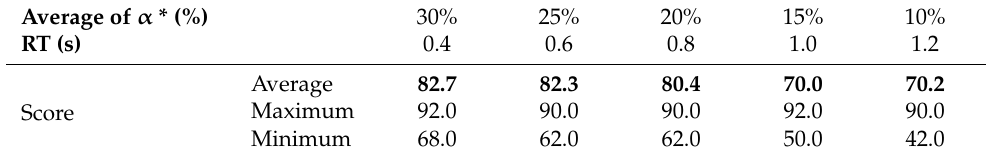
Table 9. Speech intelligibility score in the various RT conditions of the classroom.